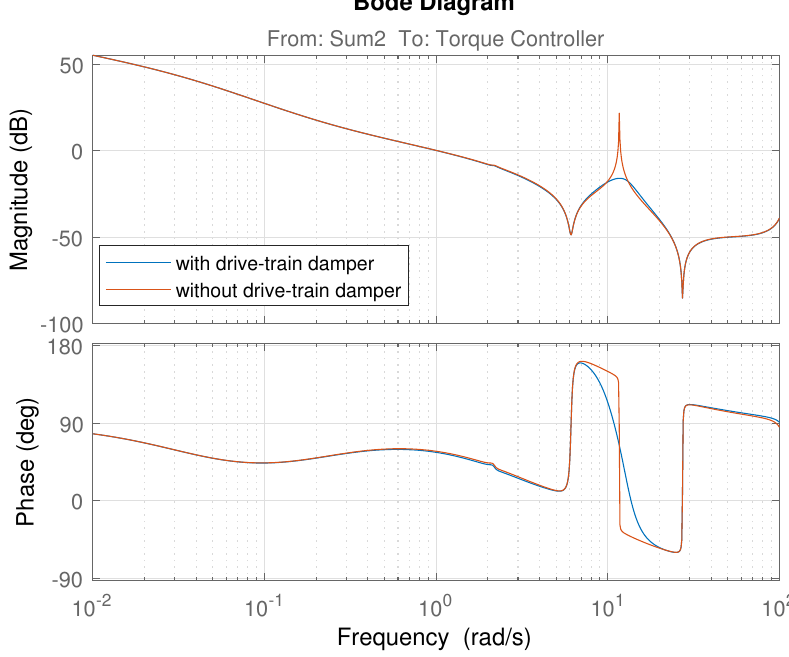
Figure 15. Open–loop frequency responses of PID controller with and without